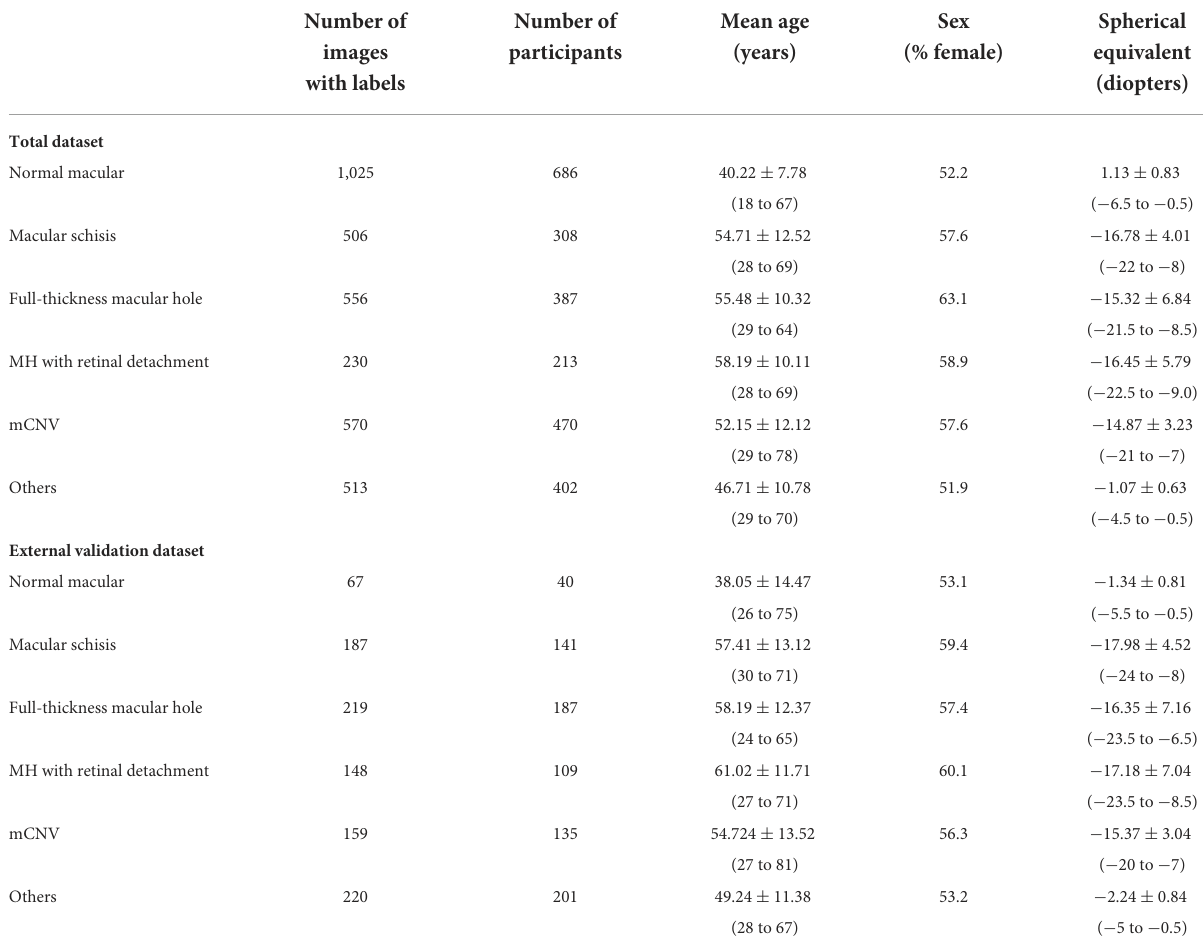
TABLE 1 Summary of the total dataset and external validation dataset. Number of